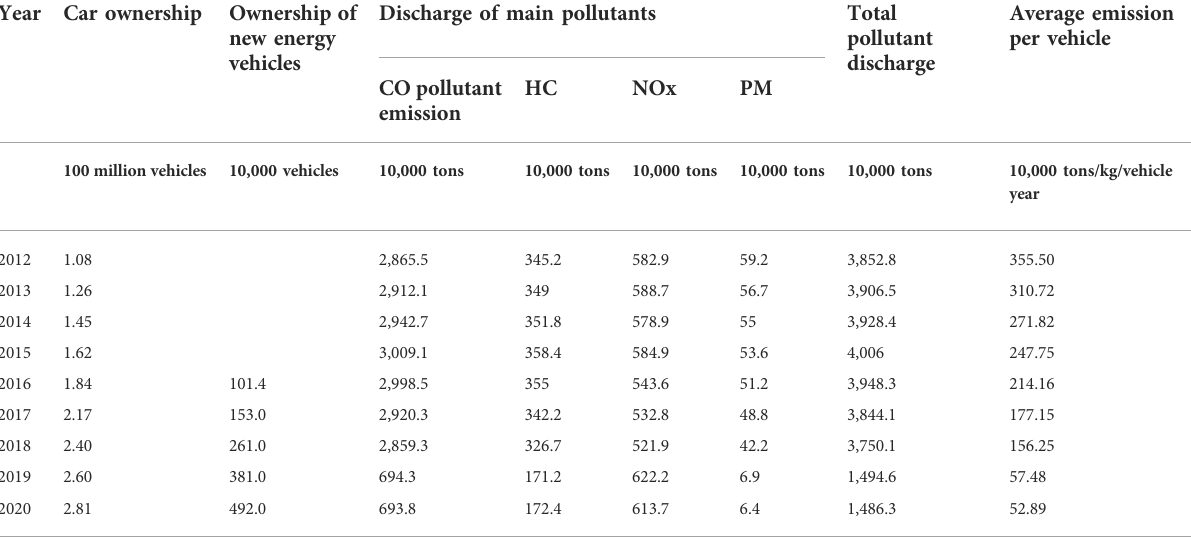
TABLE 2 Statistics of vehicle ownership and pollutant emission in China from 2012 to 2020 (Ministry of Ecology and Environment of the Peoples Republic of China, 2016).